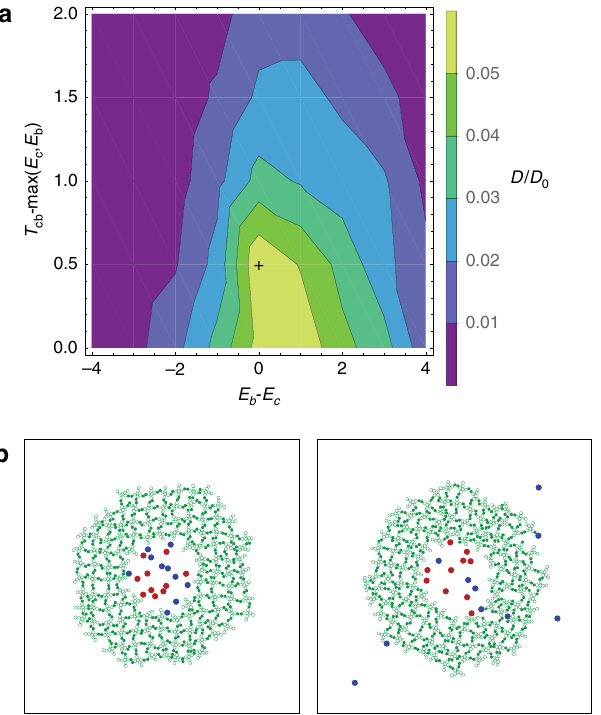
Fig. 4 Analysis of fi ltering mechanism in high af fi nity limit. a Diffusion constant as a function of E b − E c and T cb − max( E c , E b ), divided by the diffusion constant of a completely free particle with no gel. Since the energy barriers to spontaneous bond breaking are effectively in fi nite, this represents a complete search of the parameter space. The largest diffusion constant obtained is D / D 0 = 0.059 and is marked with a plus symbol. Data are averaged over 20 simulations for each point. b Demonstration of perfect fi ltering. Initially (left panel), a gel is trimmed to form a circular shell. 10 binding (blue) and 10 non-binding (red) particles are all placed within this shell. Over time (right panel), the binding particles are able to enter the gel and diffuse through it, while the non-binding particles remain in the interior. See Supplementary Movie 2